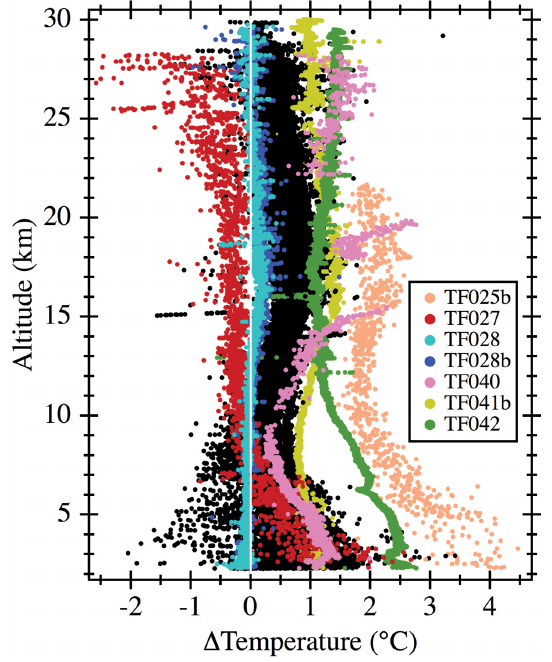
Fig. 1. Profiles of T differences between RS92 and iMet radioson- des. Seven of the 26 profiles are identified as anomalous (i.e., not conforming to the majority of difference profiles), colored and listed in the legend. Profiles denoted by the flight number plus suffix “ b ” present differences between secondary RS92 sondes and iMet son- des. The white vertical zero line serves as a visual guide.